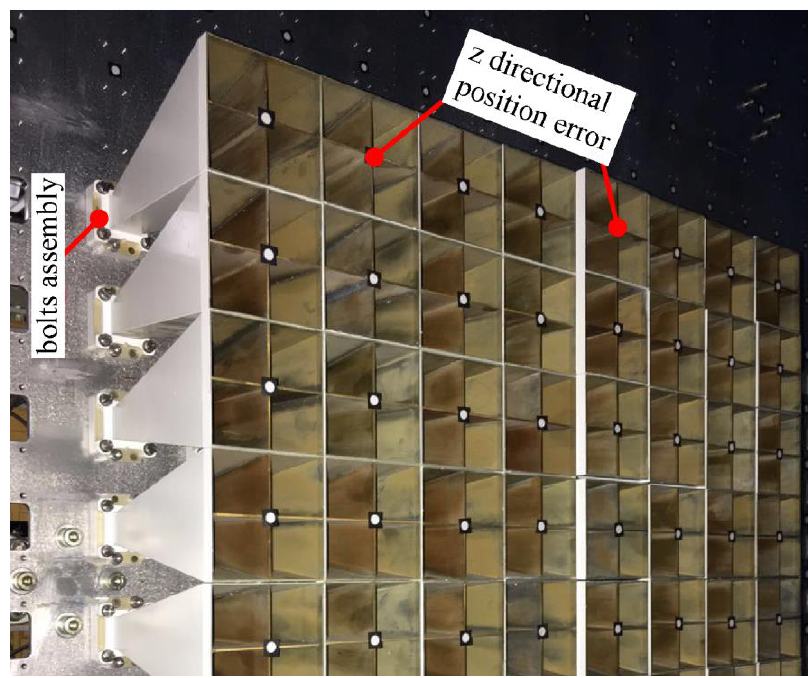
Figure 4. The z directional position error of the horn element.